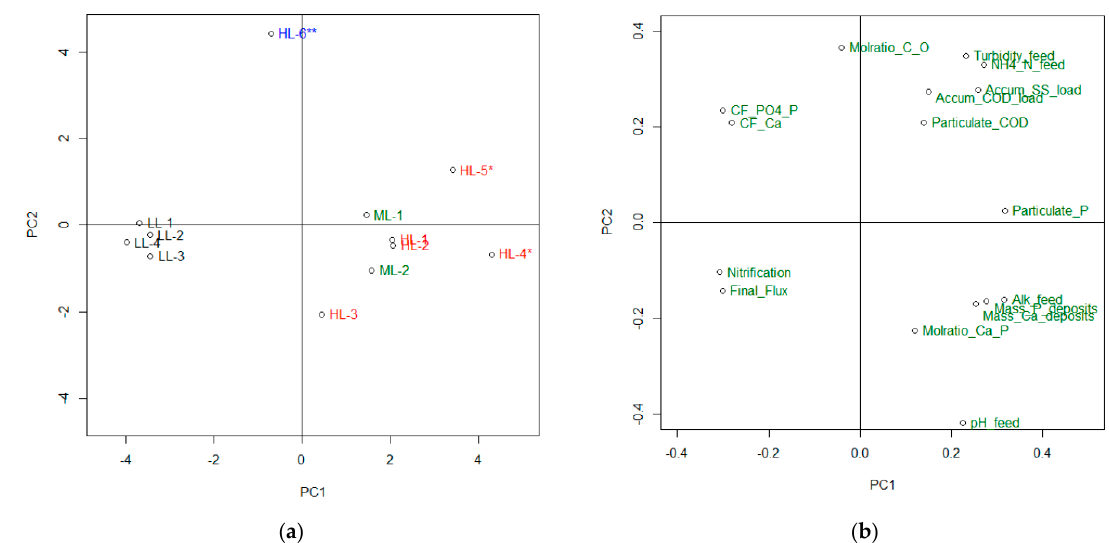
Figure 6. PCA based on 19 variables including feedwater characteristics, contaminant loading for filtered COD and SS, composition and characteristics of fouling deposits, concentration factors for P and Ca, and baseline-corrected water flux at the end of the experiments. The different variables are given self-explanatory short names to make the plots more readable. The cumulative explained variances for PC1 and PC2 are 64.4% and 82.9%, respectively. ( a ) Score plot; ( b ) Loading plot.